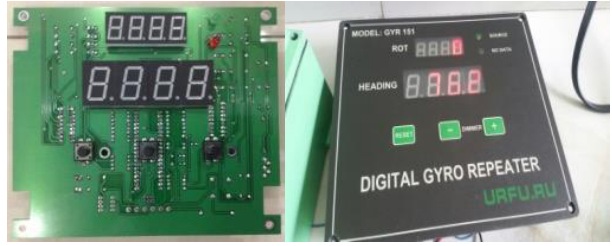
Fig. 3. Digital gyro repeater